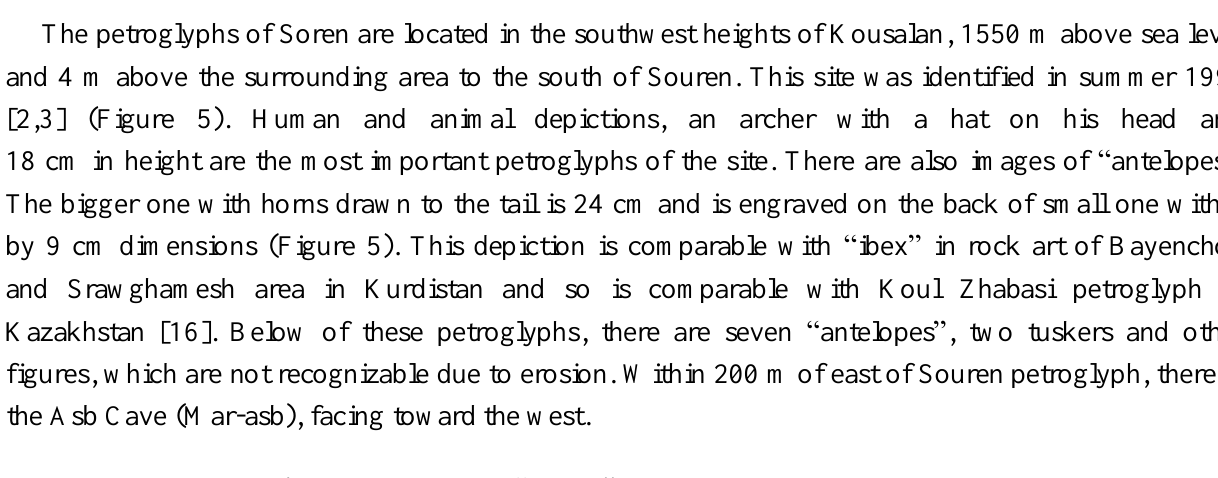
Figure 5. Kousalan, “ibexes” and Souren